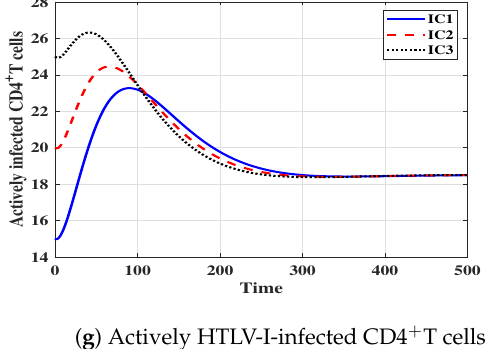
Figure 2. Solutions of system (7)–(13) with initial conditions IC1–IC3 in Case